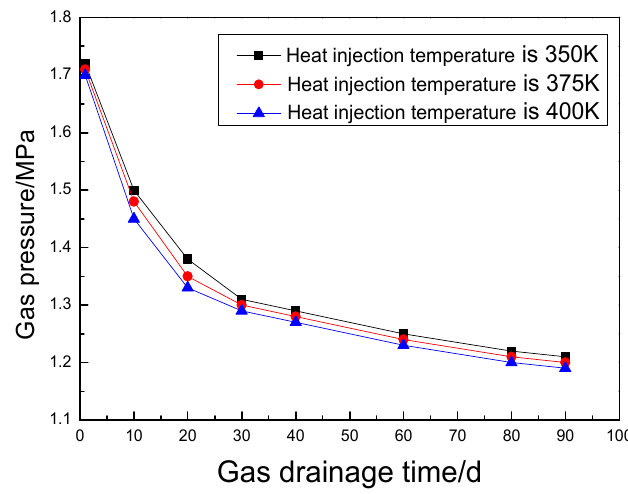
Figure 9. The variation curve of gas pressure with the drainage time at 2 m away from the borehole.